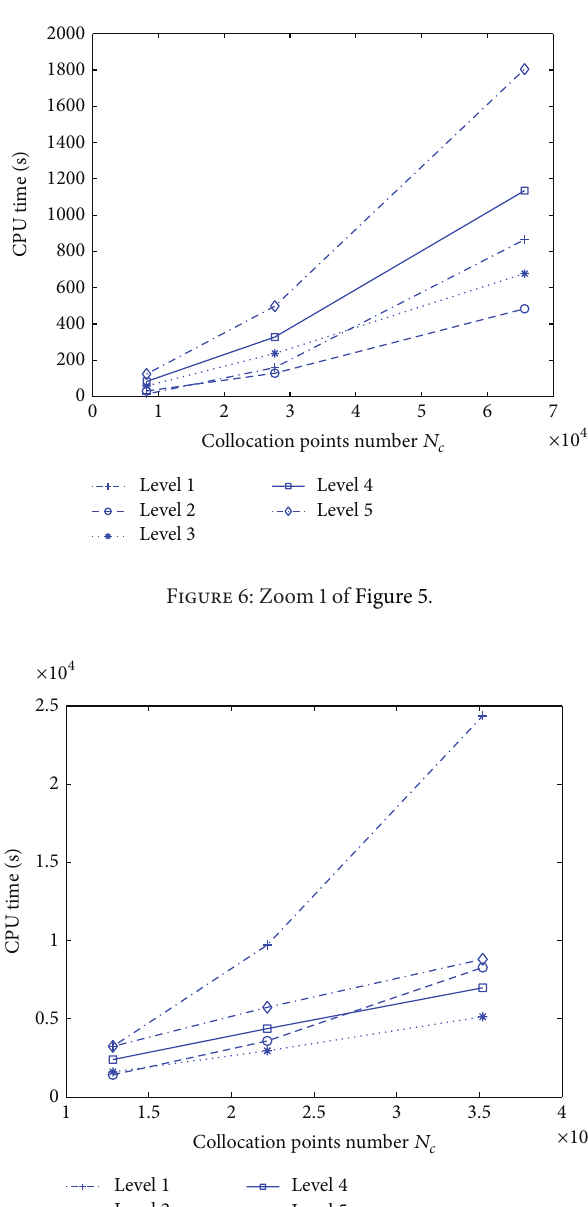
Figure 5: CPU time versus the number 𝑁 𝑐 of collocation points at different levels.